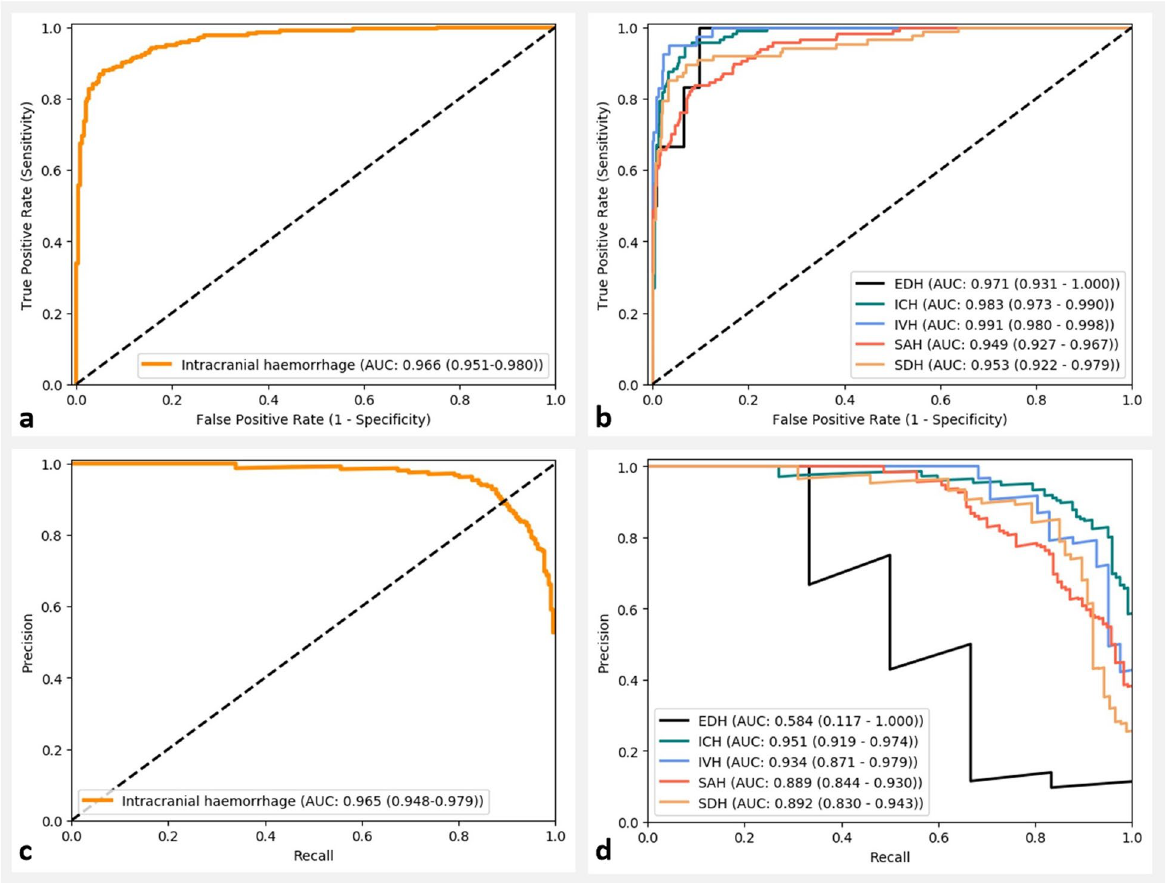
Fig. 2 ROC and PR curves for the deep learning model on the CQ500 dataset. The top two graphs show the ROC curves ( a intracranial haemorrhage; b each haemorrhage subtype). The bottom two graphs show the PR curves ( c intracranial haemorrhage; d each haemorrhage subtype). Ninety-five per cent confidence intervals are provided in parentheses for each AUC. AUC Area under the curve, EDH Extradural haemorrhage, ICH Intracerebral haemorrhage, IVH Intraventicular haemorrhage, PR Precision-recall, ROC Receiver operating characteristic, SAH Subarachnoid haemorrhage, SDH Subdural